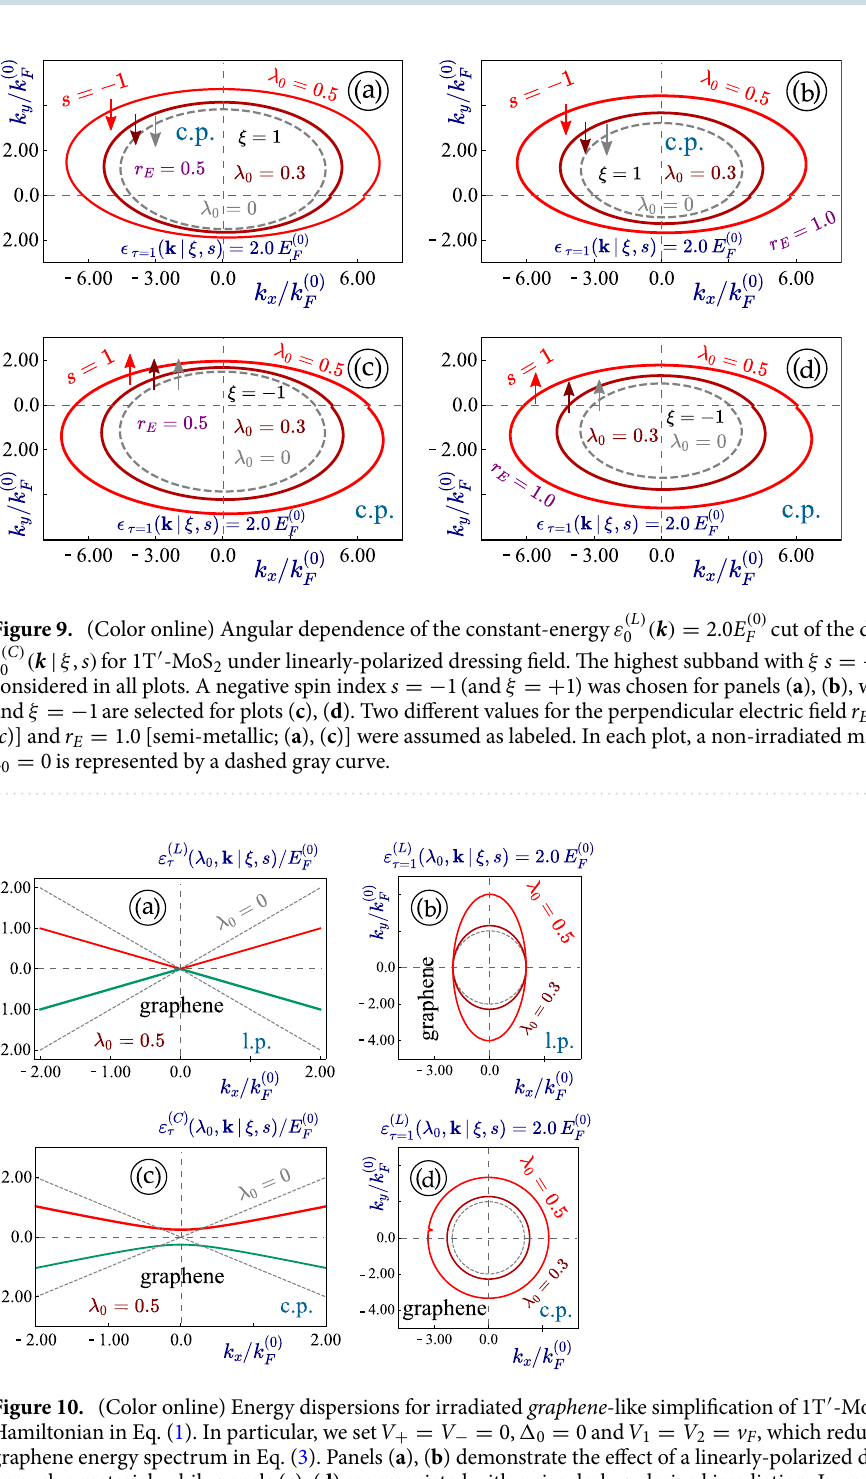
0 and V 1 0 , (cid:31) 0 V V 2 v F , which reduces to regular = = = + = − = 2.0 E ( 0 ) F ] = 1 =